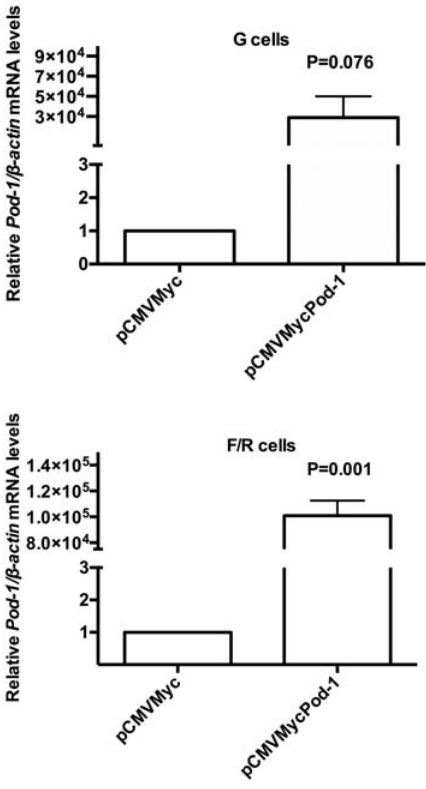
Figure 3. Quantitative reverse transcription RT-PCR (qRT-PCR) analysis of relative Pod-1/ b -actin mRNA levels in primary rat adrenal glomerulosa cells (G cells) and fasciculata/reticularis cells (F/R cells) that had been transiently transfected with the empty vector pCMVMyc or with pCMVMycPod-1. Total RNA samples used in qRT-PCR were prepared 48 h post-transfection. Data are reported as the means ± SD from three experiments. Statistical signi fi cance was assessed by paired t -tests.